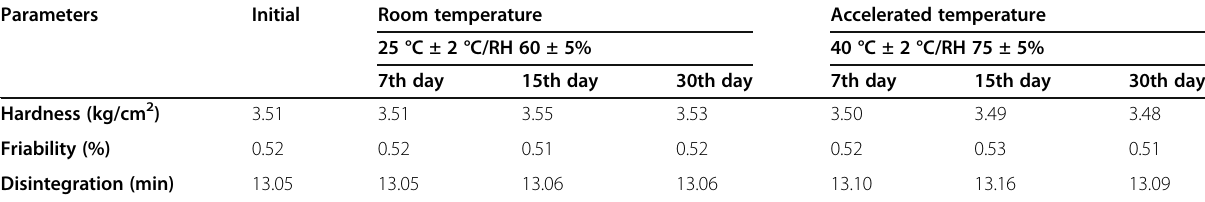
Table 9 Accelerated stability study data